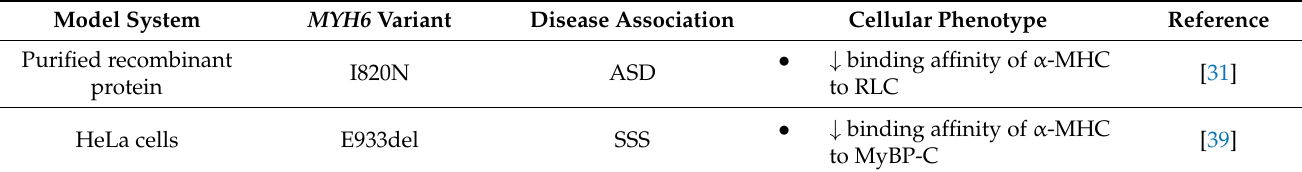
Table 2. Functional studies evaluating the role of MYH6 variants in cardiac